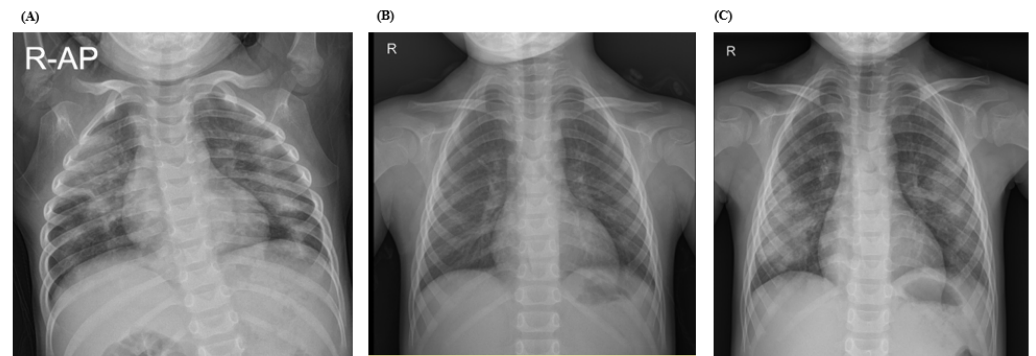
Figure 2. Progress of chest radiograph of Case 3. ( A ) Initial chest radiograph (R-AP) during the first hemoptysis event. ( B ) Resolution of diffuse pulmonary infiltrates after 2 months of systemic corticosteroid treatment and cow’s milk restriction. ( C ) Recurrence of pulmonary infiltrate after cow’s milk provocation test.